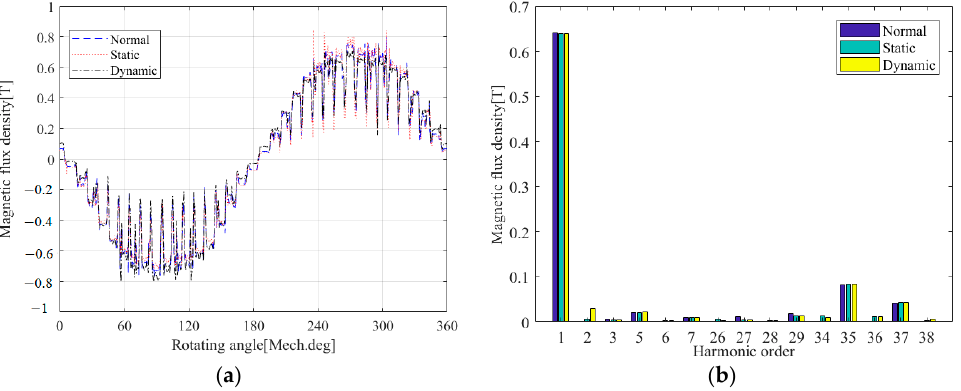
Figure 10. The magnetic lines distribution and the magnetic density diagram of the motor under dynamic eccentric conditions: ( a ) magnetic lines distribution; ( b ) magnetic density diagram.